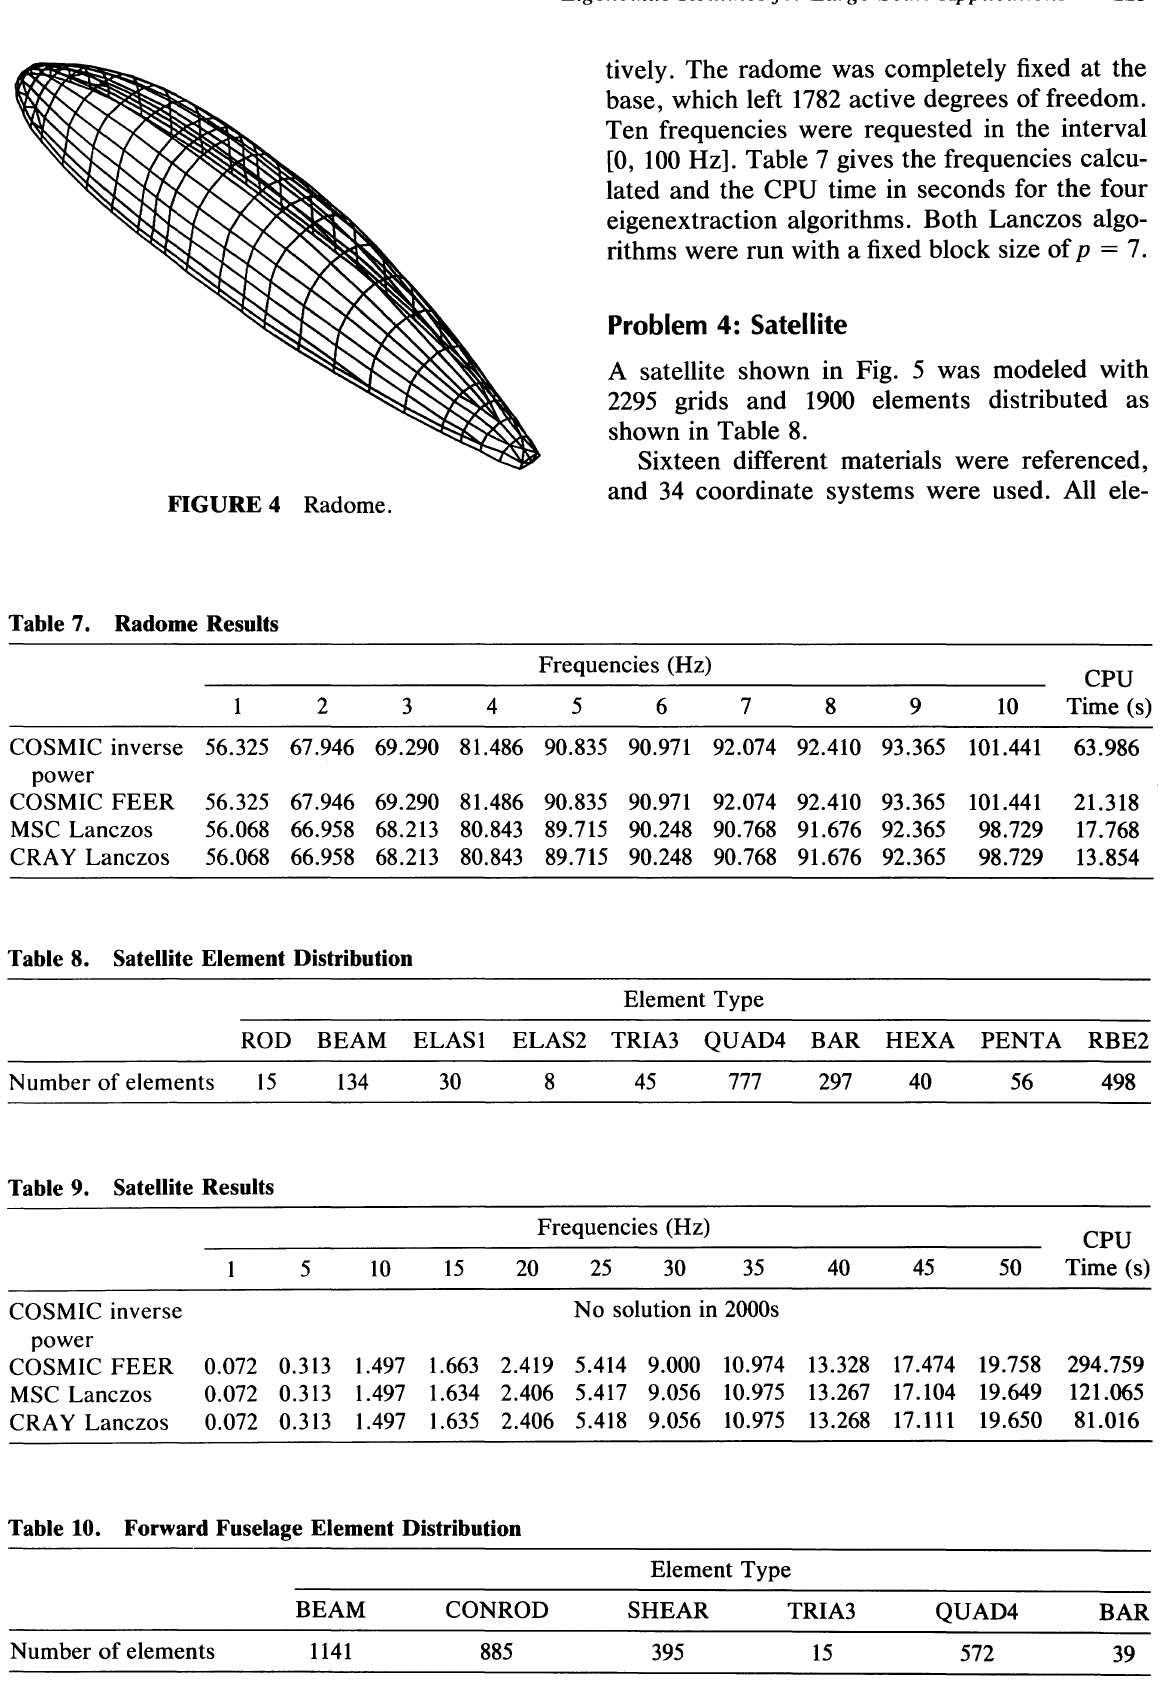
Table 10. Forward Fuselage Element